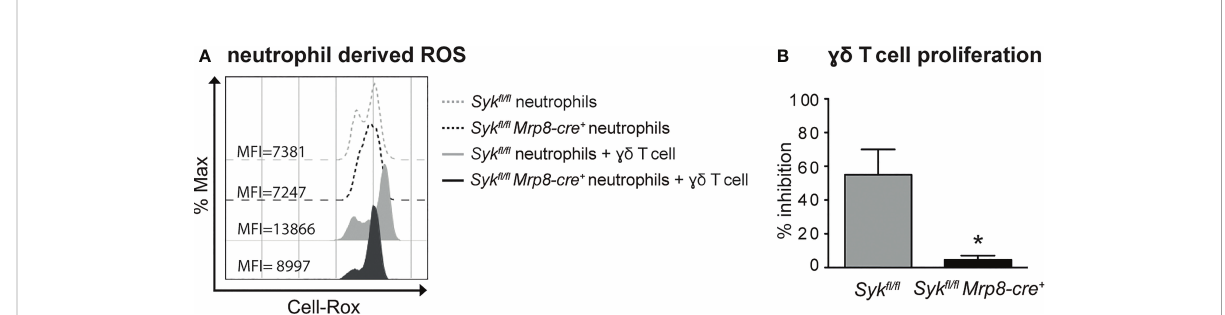
FIGURE 7 ROS-mediated inhibition of gd T cell proliferation by neutrophils requires the activation of Syk-dependent signaling pathways. gd T cells were stimulated with CD3/CD28, 100 ng/ml IL-23 plus 10 ng/ml IL-1 b and cultured with neutrophils from Syk fl / fl or Syk fl / fl Mrp8-cre + mice for 3 (A) or 72 (B) hours. (A) Representative FACS histogram plots depicting the CellROX MFI of CD11b + Ly6G + neutrophils from Syk fl / fl or Syk fl / fl Mrp8-cre + mice in the presence or absence of gd T cells, as evaluated by FACS analysis. (B) Percentages of inhibition of gd T cell proliferation by neutrophils from Syk fl / fl or Syk fl / fl Mrp8-cre + mice, as measured by BrdU incorporation. Graph values indicate means ± SD from 2 independent experiments. * P ≤ 0.05 by t